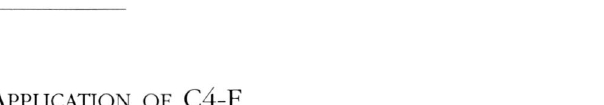
Fig. 3. - (A) PCR detection of Giardia intestinalis WB (assemblage A) and GS (assemblage B) strains using various primers, SSU-rDNA primers, giardin primers, tim primers, or GLOFR-C4 primers. W repre­ sents WB whereas G indicates GS isolate. Using these isolates as the templates, PCR was performed using the following primers. Lane 1, DNA size marker. 100 bp ladder; lane 2. 3, JW1 and JW2 (for SSU-rDNA); lane 4, 5, RH11 and RH4 (for SSU-rDNA); lane 6, 7, GGL and GGR (for giardin); lane 8, 9. П30 and 4131 (for tim); lane 10.11, 5925 and 7493 (for tim); lane 12, 13, C4-F and C4-R (for GLORF-C4). (B) Grouping of Giardia intestinalis using ftm-specific primers and GLORF-C4 primers. W represents WB whereas G indicates GS iso­ late. Using these isolates as templates, reactions were carried out with the following primers and the resultant PCR products were digested with indicated restriction endonucleases. lane 1, DNA size marker, 100 bp ladder; lane 2, 3, 4130 and 4131 (Xhol); lane 4, 5, 5925 and 7493 (Hind III); lane 6, 7, C4-F and C4-R (Tni9 I); lane 8, 9, C4-F and C4-R (Nco